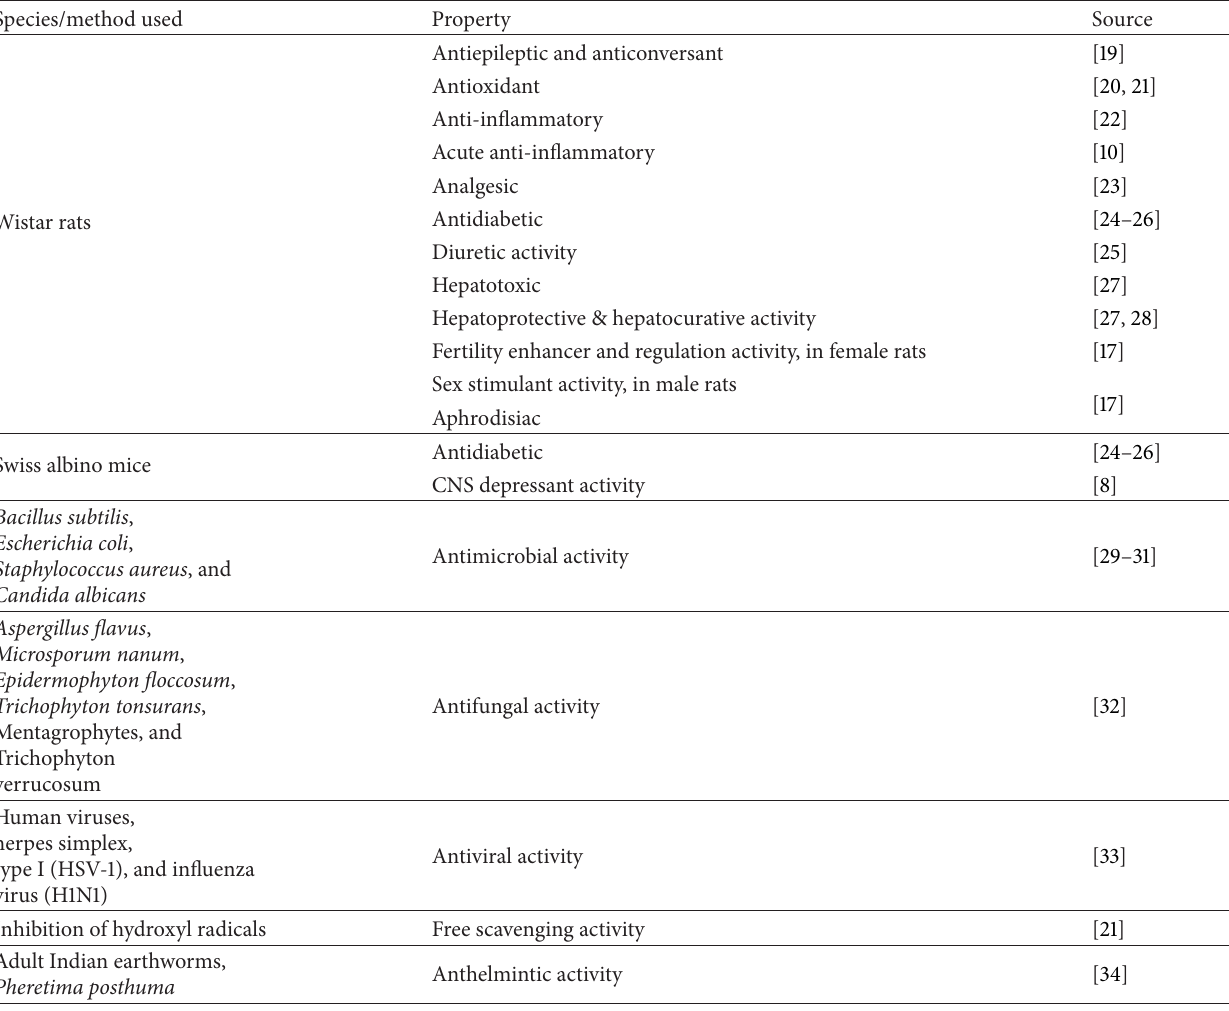
Table 7: A summary of reported pharmacological activity of P. odoratissimus